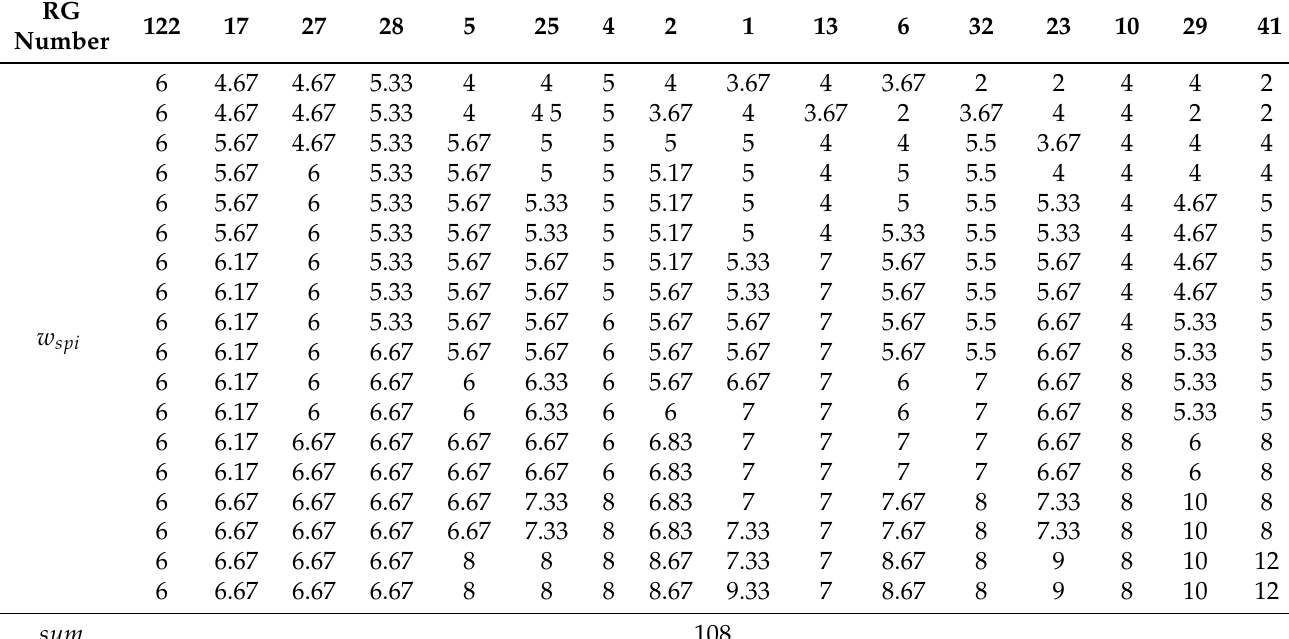
Table 7. Values of w spi coefficient obtained by simulation for the different fourth-degree